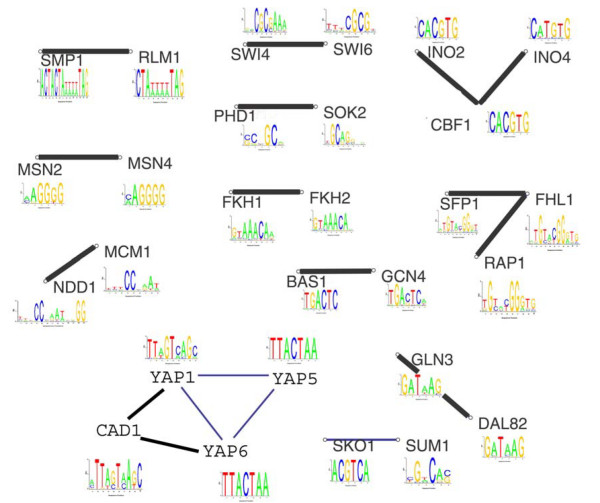
Transcription factors with overlapping binding sequences in S. cerevisae. Nodes represent TFs, edges connect pairs of TFs if their corresponding sets of binding sequences have significant overlap according to the present measure. Bold edges connect TFs which also have biological similarity according to the functional annotation and transcription network (gene co-regulation) measures. Shown are the TF logos [11]. Logo length was limited to the highly conserved base pairs for clarity.